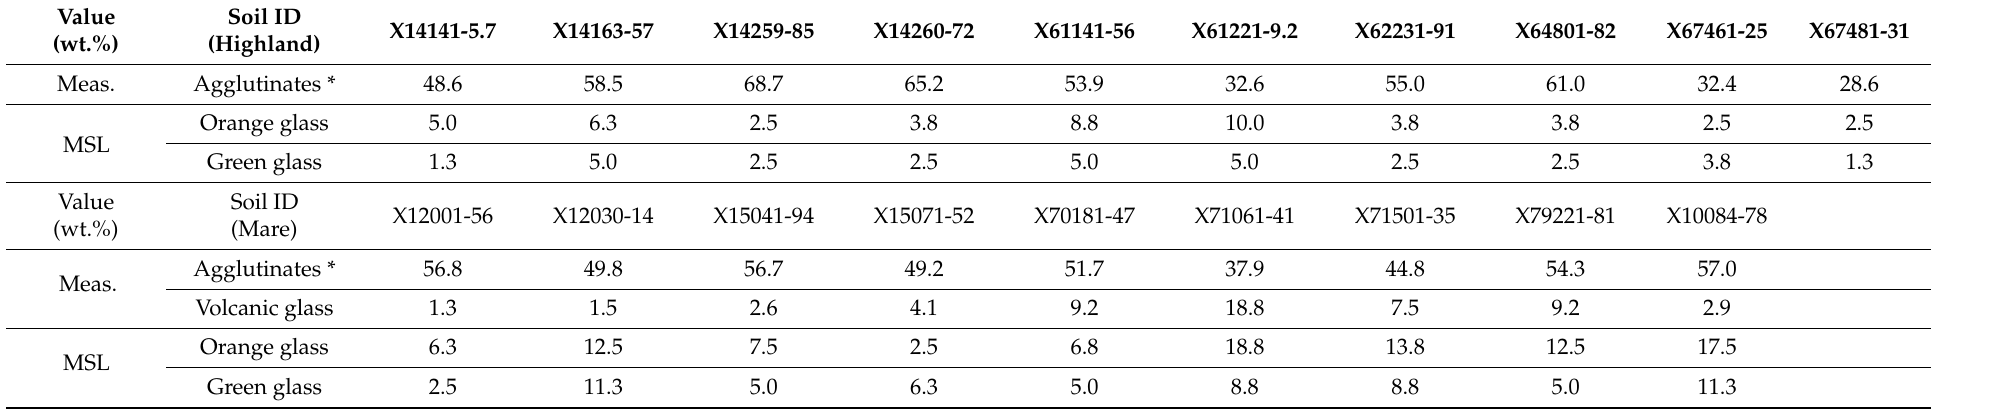
Table 3. The abundance of glasses obtained from the LSCC measurement and the MSL retrieval results.